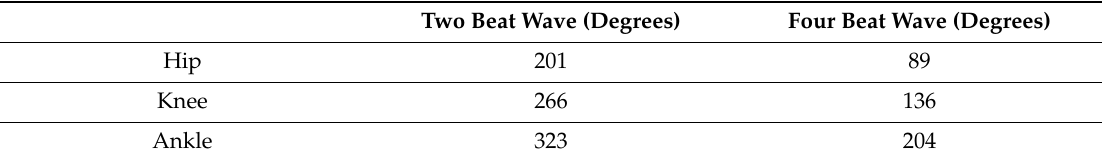
Table 2. Phase (degrees) of the two-beat travelling wave and the four-beat travelling wave of a typical national level butterfly swimmer for the oscillations of the hip, knee, and ankle ([13] Sanders, 2007). Two Beat Wave (Degrees) Four Beat Wave (Degrees) 201 89 266 136 323